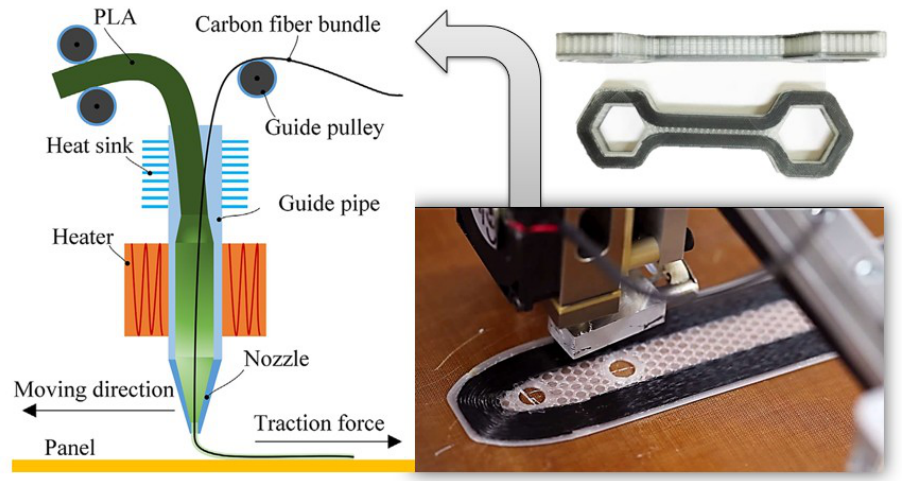
Figure 4. Continuous carbon fiber (CF) additive manufacturing for carbon fiber reinforced polymer composites (CFRPs) fabrication.